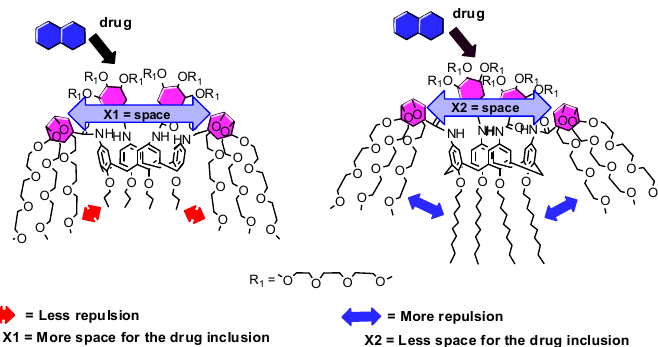
Figure 1. Representation of the relationship between alkyl chain and space for the drug molecule inclusion (X1 > X2).